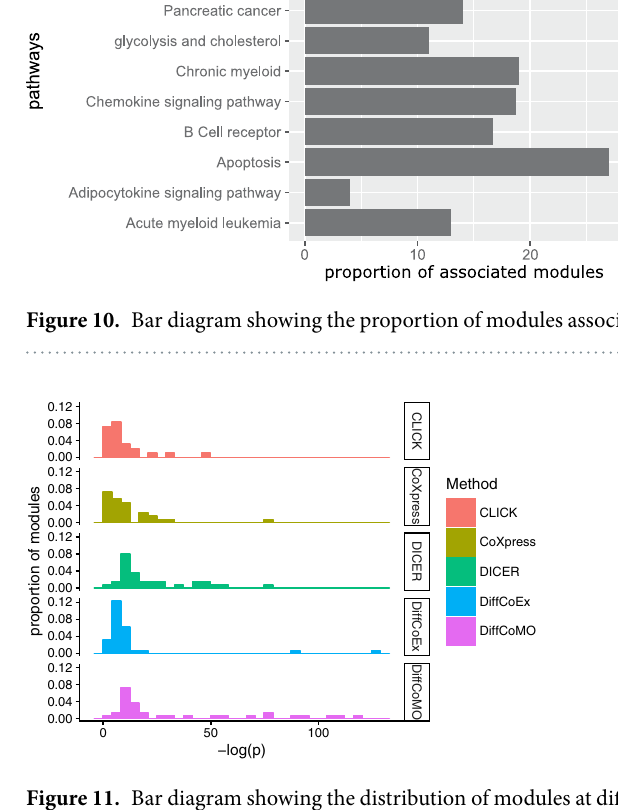
Figure 11. Bar diagram showing the distribution of modules at different p-values. p-value of a module closer to zero signifies that it is less likely to observe the annotation of a particular GO term to a group of genes occurs by chance. X-axis represents − log ( p ) whereas Y-axis represents proportion of modules identified by four algorithms. When p-value is lower − log ( p ) approaches to higher